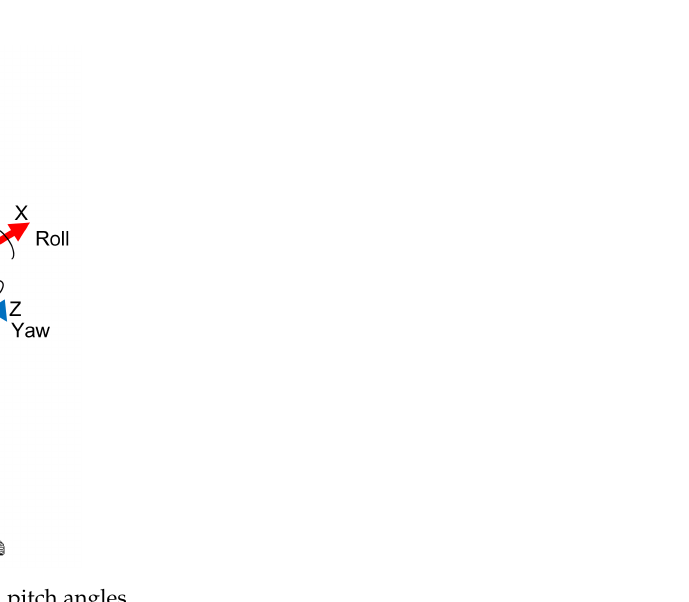
Figure 4. Pole roll, yaw and pitch angles.